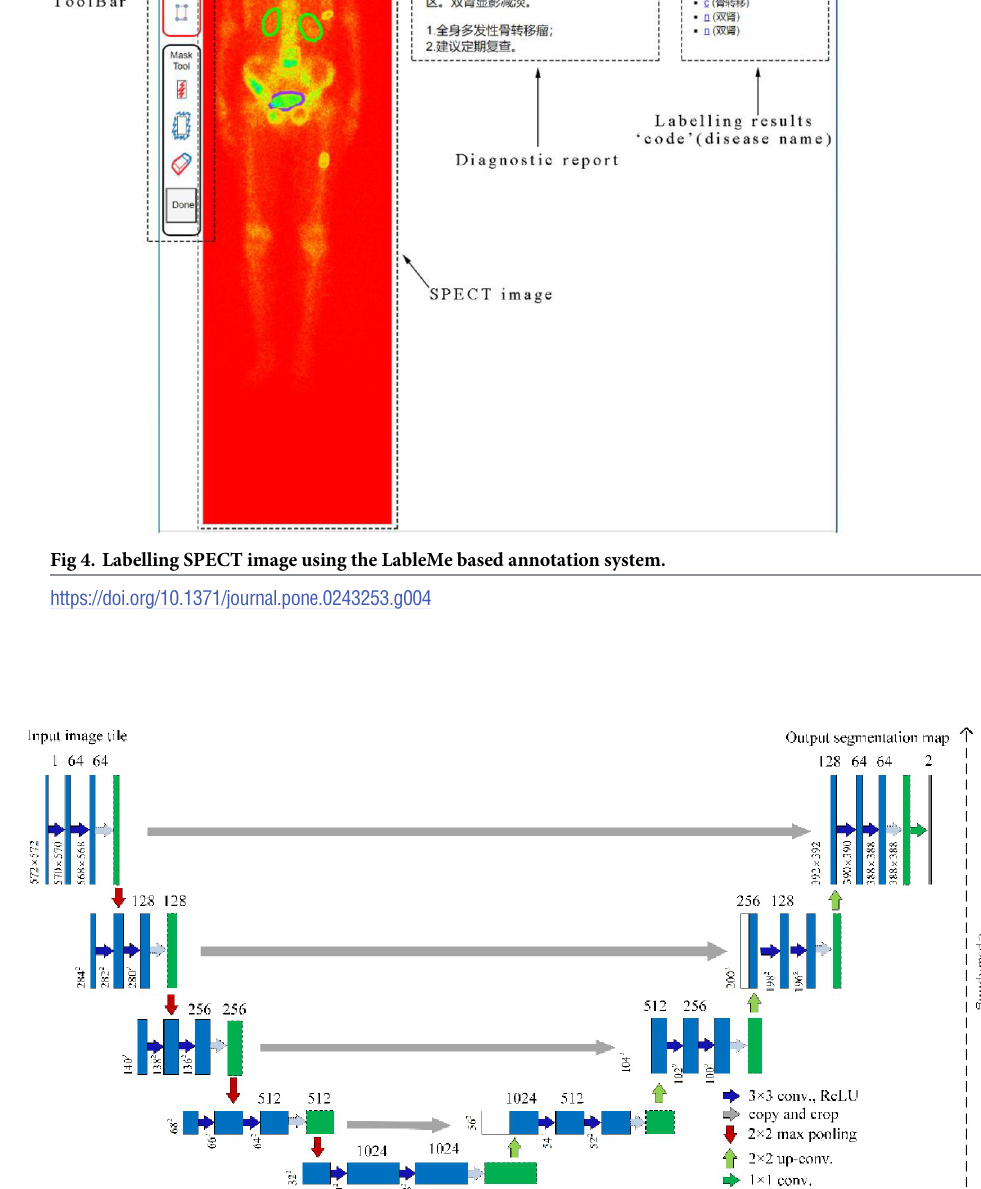
PLOS ONE | https://doi.org/10.1371/journal.pone.0243253 December3,